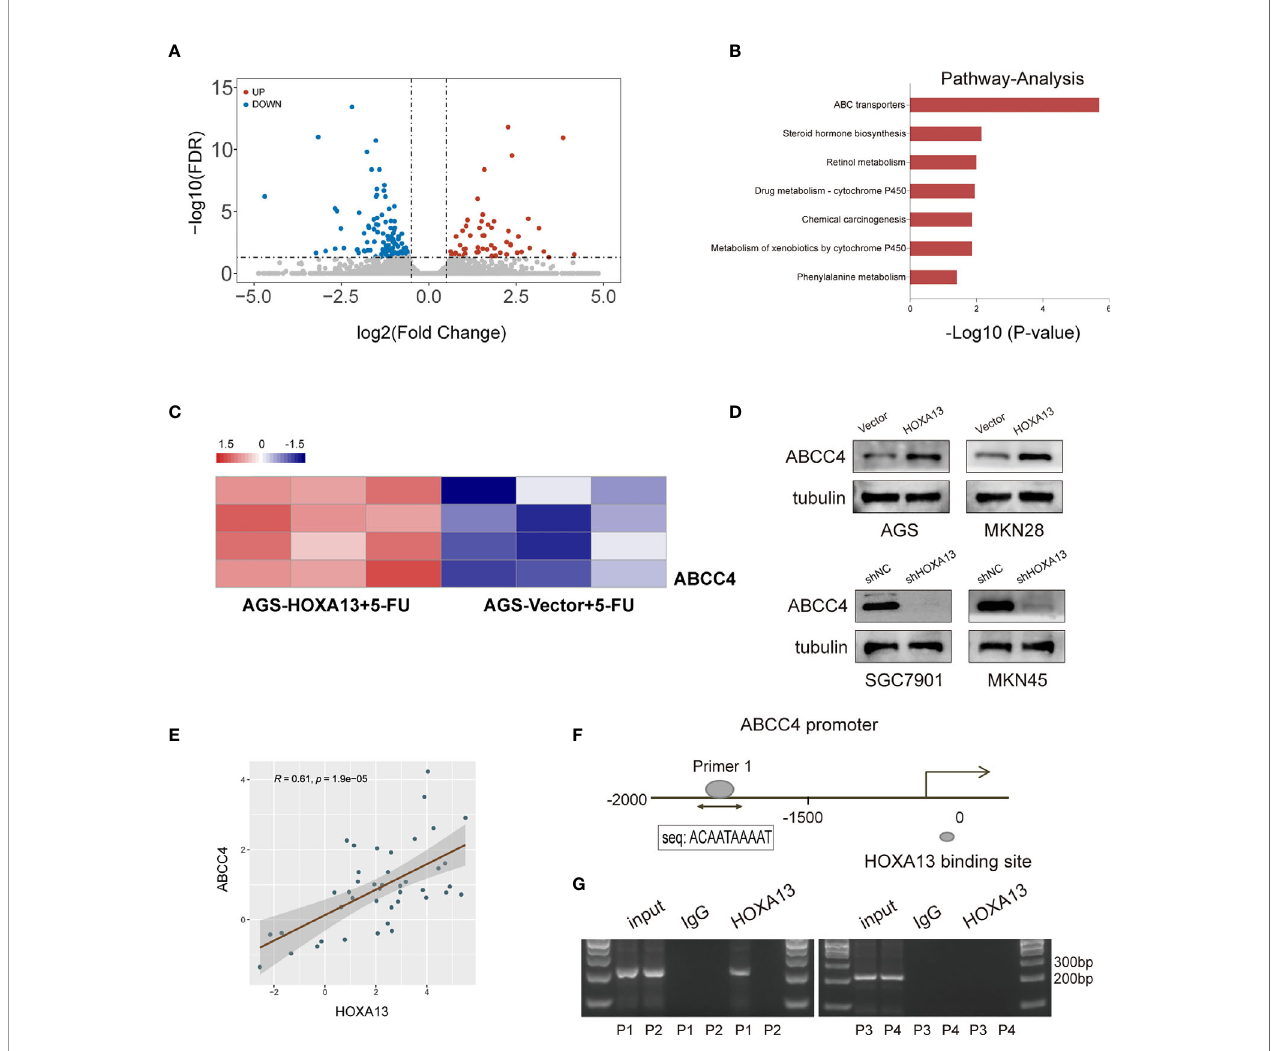
FIGURE 4 | HOXA13 upregulates ABCC4 expression via binding to its promoter region. (A) Volcano plot showed signi fi cantly upregulated genes in AGS-HOXA13 + 5-FU relative to AGS-Vector + 5-FU. (B) Pathway analysis revealed that ABC transporter pathway was signi fi cantly enriched. (C) Heatmap showed that ABCC4 was obviously upregulated in ABC transporter family. (D) The protein expression levels of ABCC4 in the indicated cell lines with altered HOXA13 expression. (E) Pearson ’ s correlation analysis of the mRNA levels of HOXA13 and ABCC4 in GC samples. (F) HOXA13 binding to the ABCC4 promoter region was predicted by JASPAR (http://jaspar.genereg.net/). (G) The results of ChIP assay and agarose gel electrophoresis indicated HOXA13 enriched in primer 1 within the ABCC4